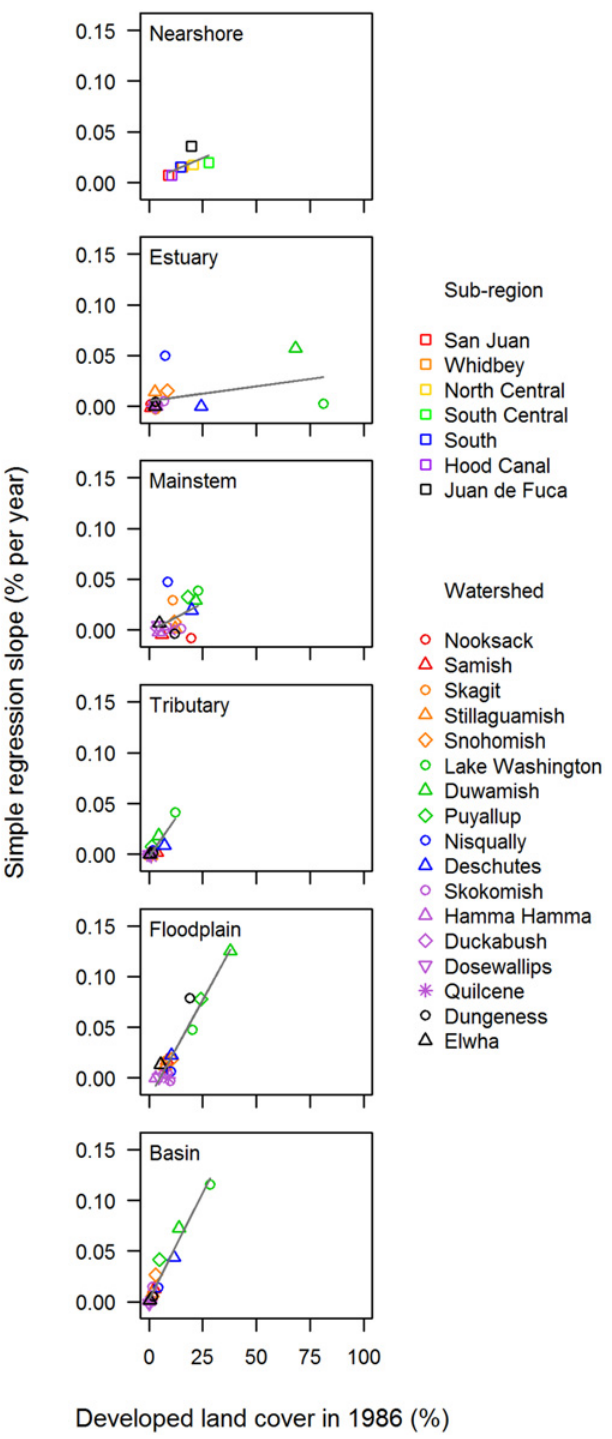
Fig 5. Percentage of Developed Land Cover in 1986 vs. Annual Change in Developed Land Cover ( b 0 ): Watershed Scale. The relationship between the percentage of developed land cover in 1986 and the annual rate of change in the percentage of developed cover ( b 0 in Eq 1), for each of six habitat areas. The line in each panel illustrates the fitted least-squares linear